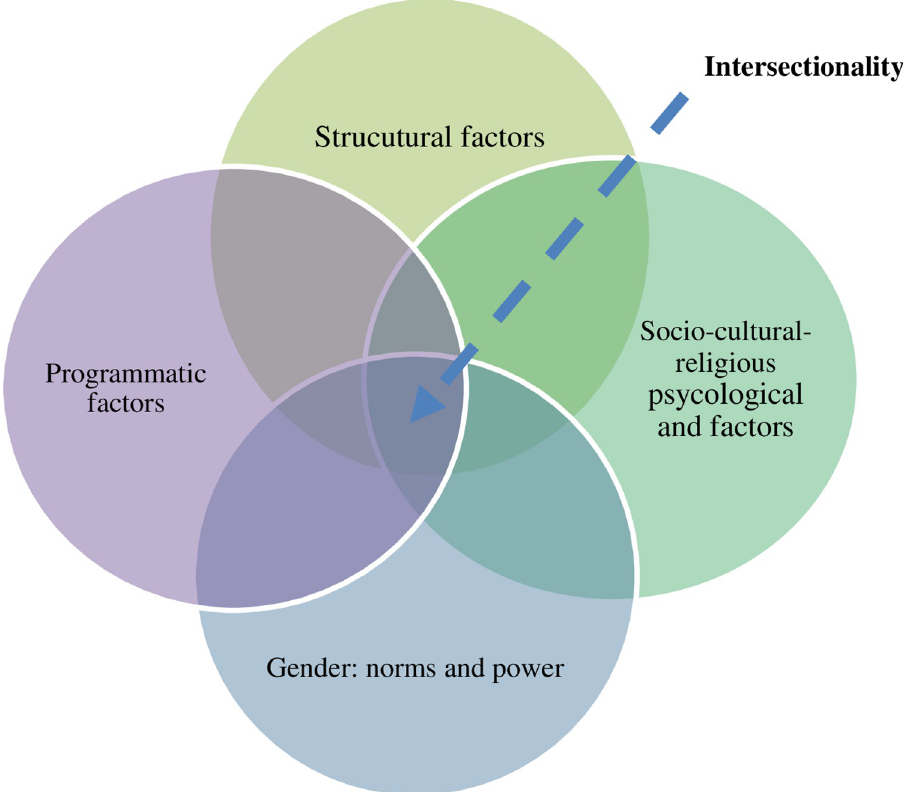
Fig 2. Multi-level intersectionality of structural, socio-cultural, programmatic factors and gender in RMNCH.